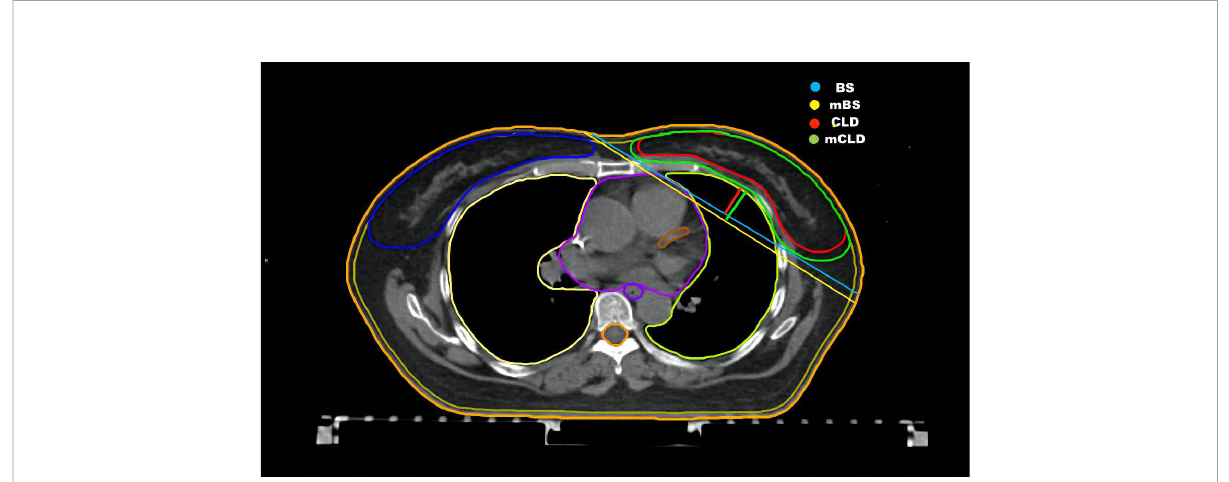
FIGURE 4 Anatomic parameters in the supine CT. The central plane from the low edge of clavicular head to the cardiac apex in the supine CT. The breast separation (BS) is the distance between entry points of two opposing beams on the central plane. The central lung distance (CLD) is the perpendicular distance from chest wall to the posterior boarder of the tangential fi elds.The modi fi ed breast separation (mBS) is the distance from the border of the sternum and the anterior border of latissimus dorsi then extending to skin.The modi fi ed central lung distance (mCLD) is the maximum perpendicular distance from BS to the posterior part of the anterior chest